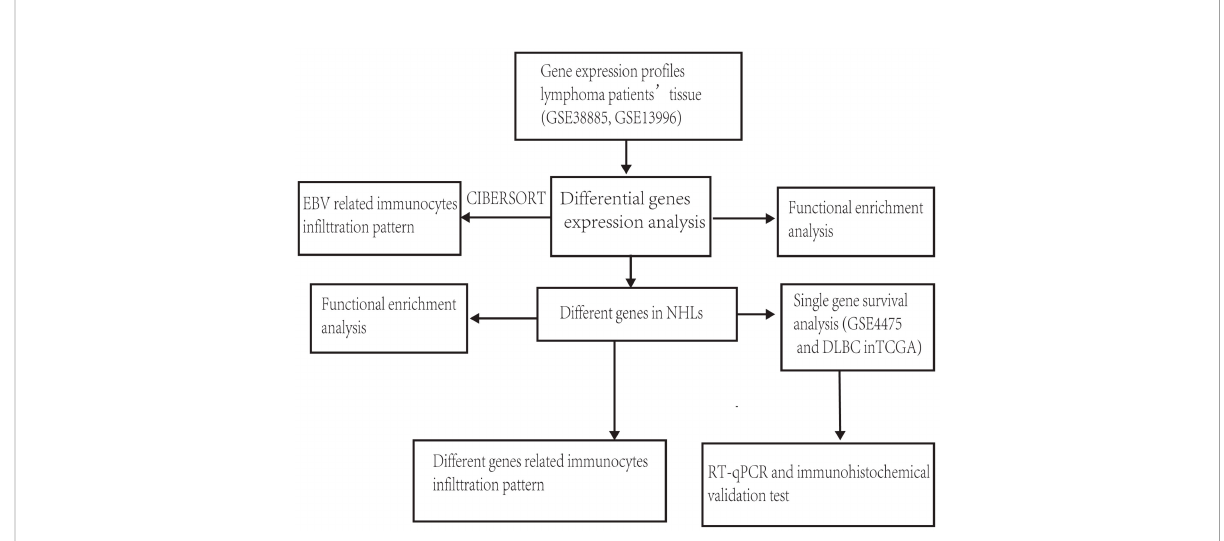
FIGURE 1 Flow chart of methodologies is used in this